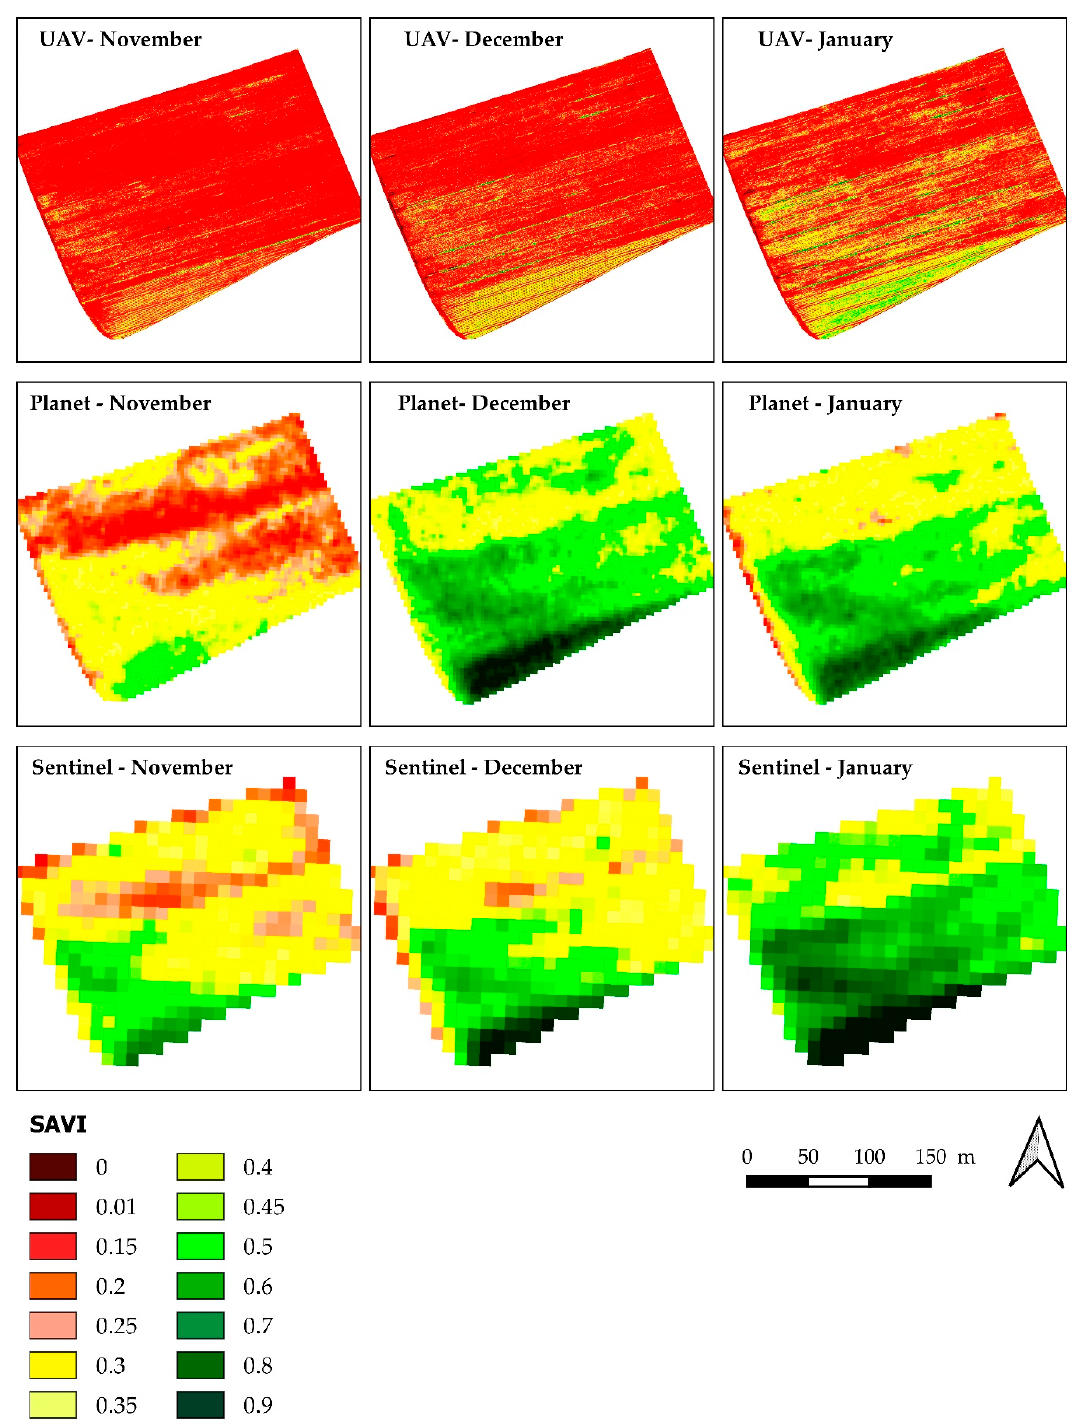
Figure 4. SAVI (soil adjusted vegetation index) maps, showing onion crop, derived from the platforms UAV ( top ), satellite PlanetScope ( center ), and Satellite Sentinel-2 ( bottom ) at their native resolutions (5 cm for UAV, 3 m for PlanetScope, and 10 m for Sentinel-2).